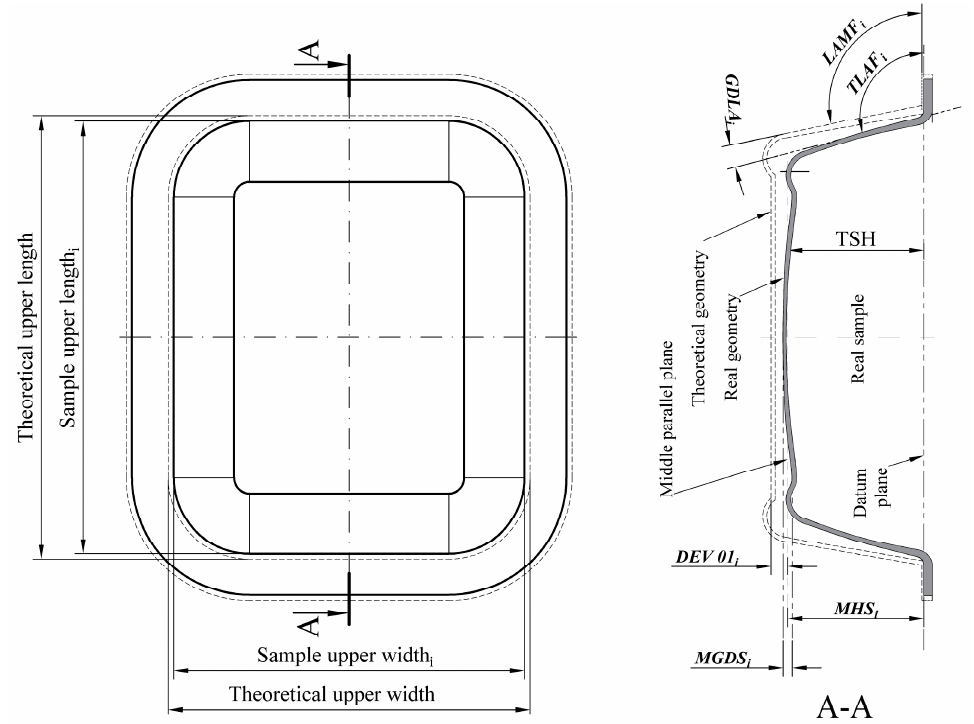
Figure 2. Product standard: dimensions on piece or dimensional deviations parameters.